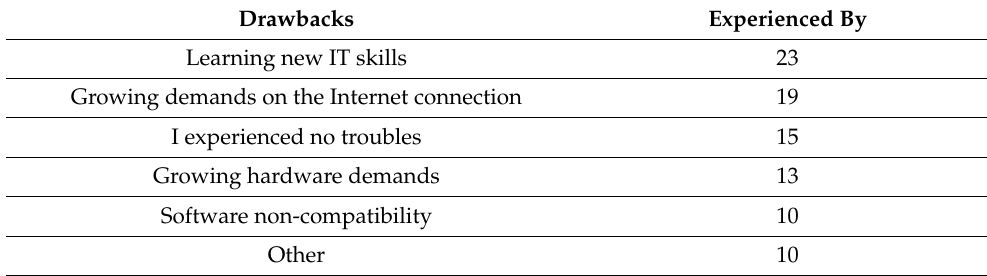
Table 6. Drawbacks of